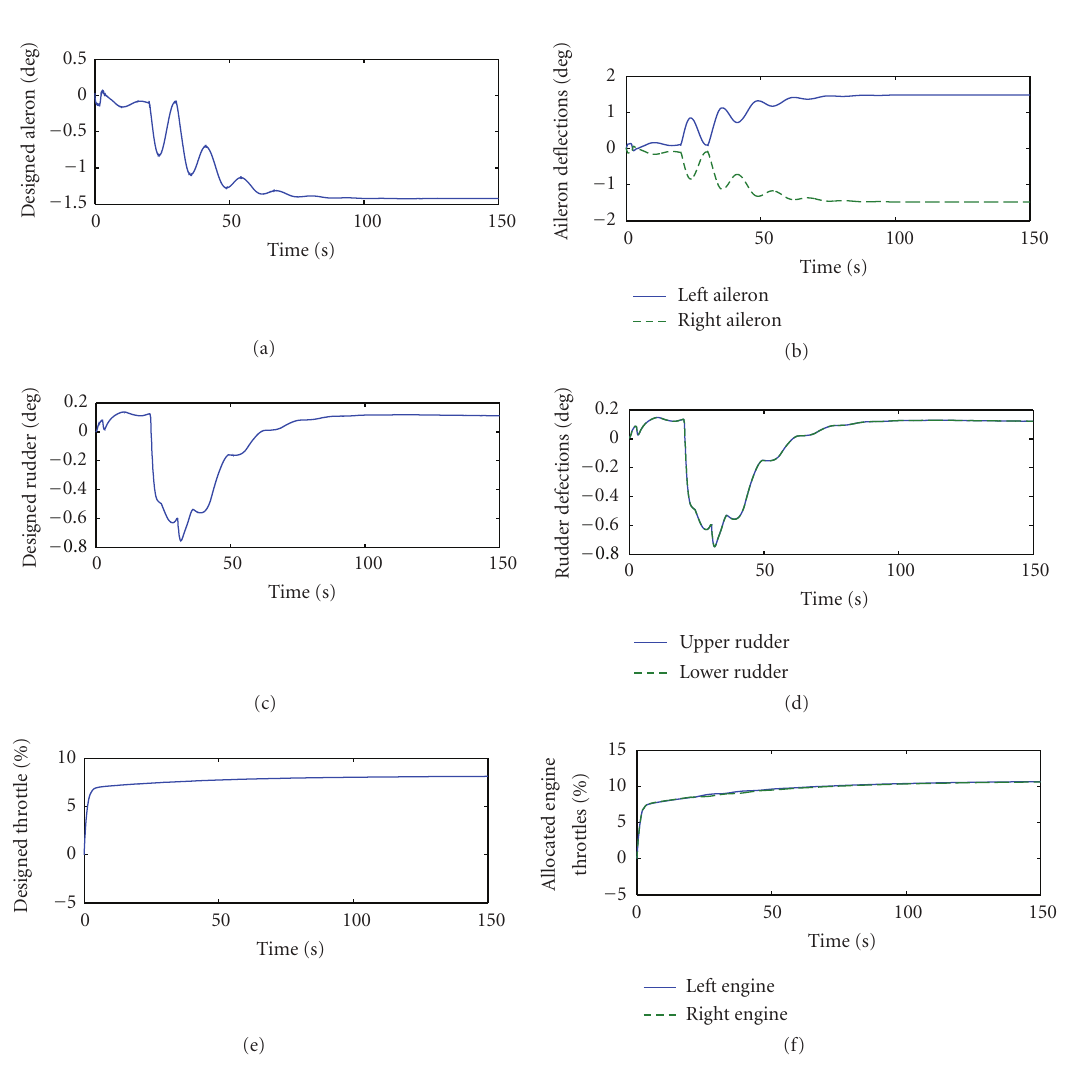
elevator failures. These disturbances are regulated by the ailerons and asymptotic tracking of the lateral states can be also achieved. altitude of the aircraft. From the ground track plot, we can see the e ff ect of asymmetric failure on the lateral dynamics. The deviation is corrected by the lateral actuators. Figure 20 shows the lumped elevator signal, allocated elevator signals, and the actual elevator deflections. The elevator failures appear as constant (step signals) on the lower plot, and the designed and allocated elevator signals are shown to accommodate for the failures after their occurrence. The input signals and outputs of other actuators are shown in Figure 21. Note the actuation of the aileron and rudder required to compensate for the asymmetric failure. The time history of the control allocation gains and some selected adaptive parameters are shown in Figures 22 and 23. It can be seen that the allocation gains and controller parameters are updated autonomously to ensure the desired